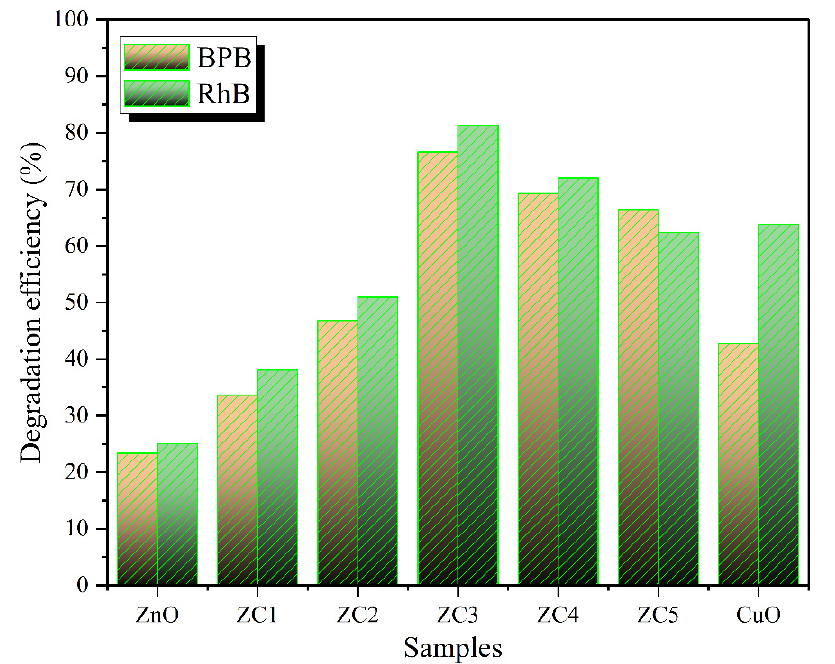
Figure 5. Photocatalytic degradation of BPB and RhB over ZnO, CuO, and ZnO/CuO (dye concen- tration = 10 mg L − 1 , catalyst dose = 20 mg, irradiation time = 30 min).